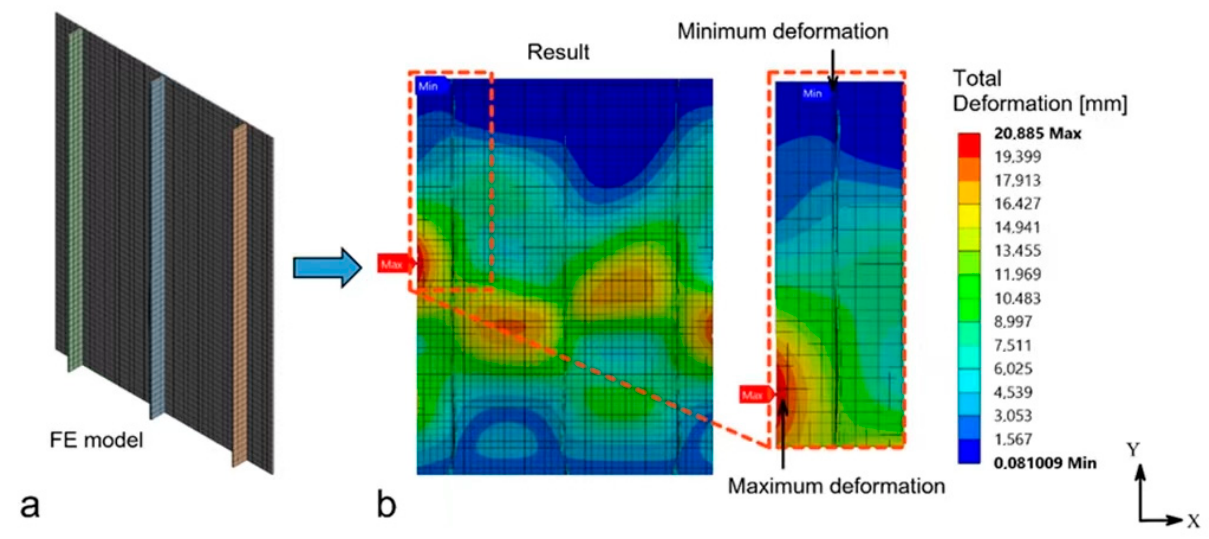
Figure 5. Typical finite element mesh on Specimen A. ( a ) FE model; ( b ) FE result with the deformation contour.